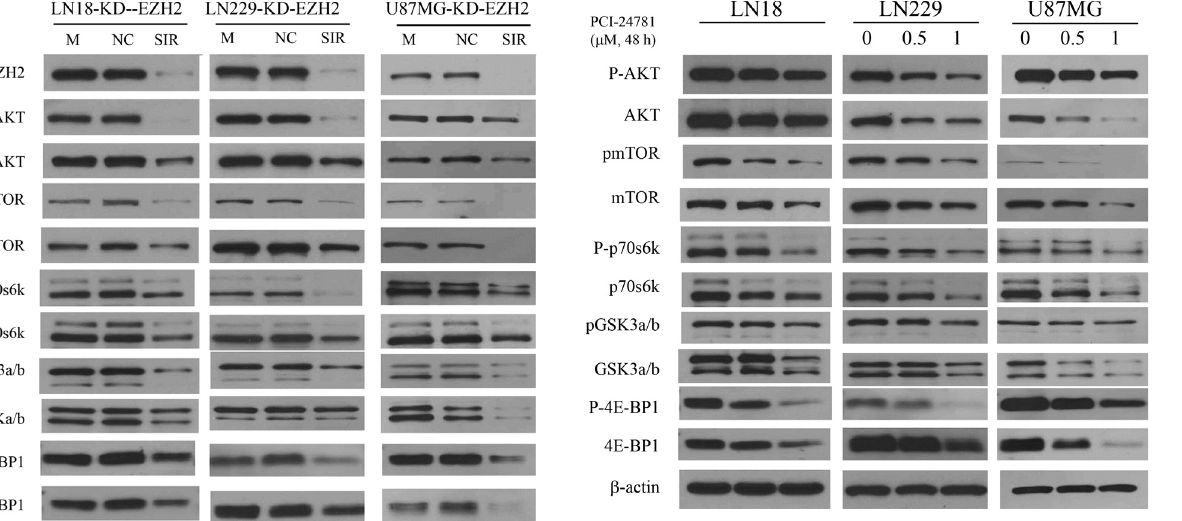
Figure 6 - Treatment with PCI-24781 attenuated the expression of pro- teins involved in the PI3K/Akt signaling pathway. The blots are represen- tative of 3